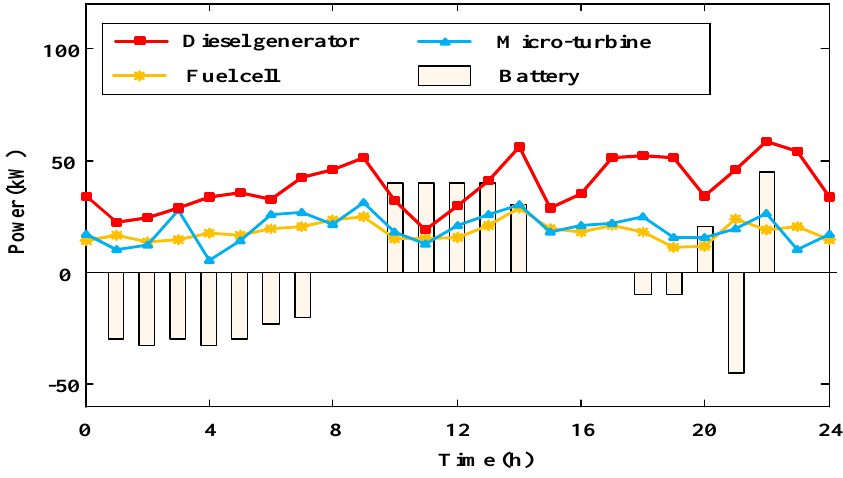
Figure 8. Output power of energy storage system and fossil energy carriers.